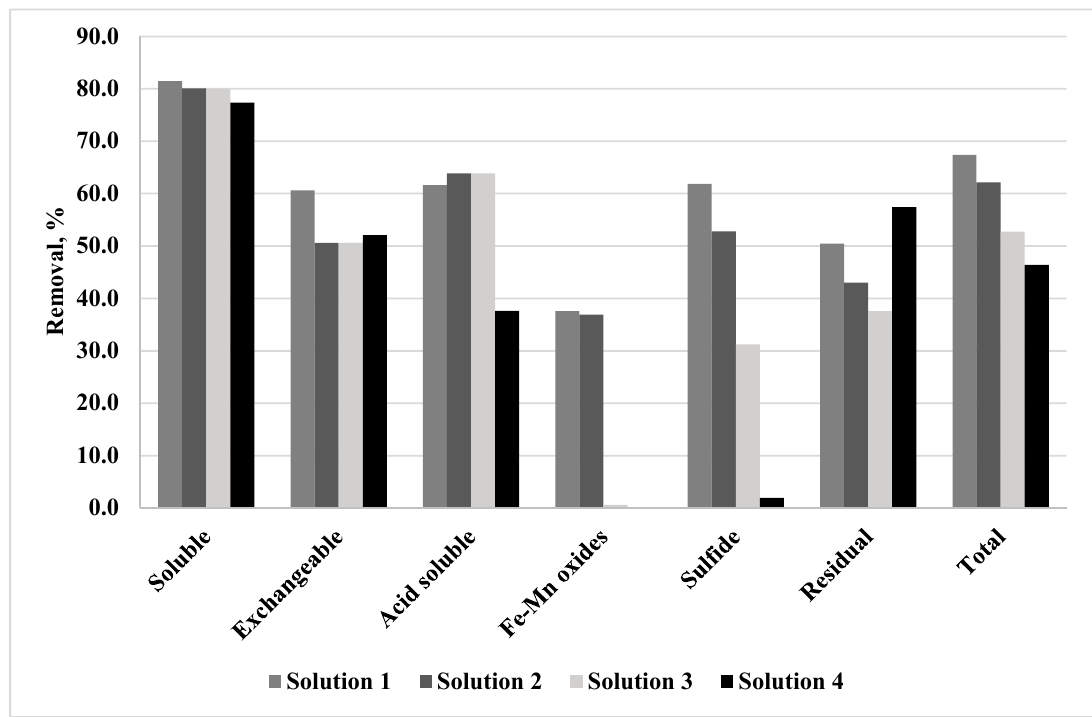
Figure 2. Global copper removal efficiencies for each fraction and pre-treatment solution from anode to cathode.